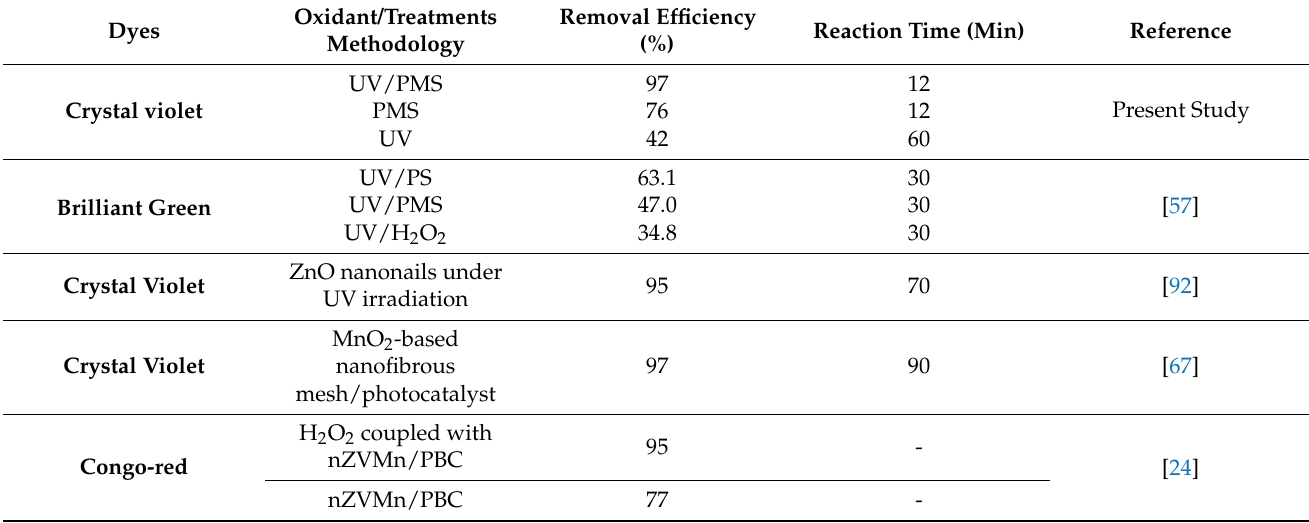
Table 4. Comparison of removal efficiency for various dyes of different catalyst